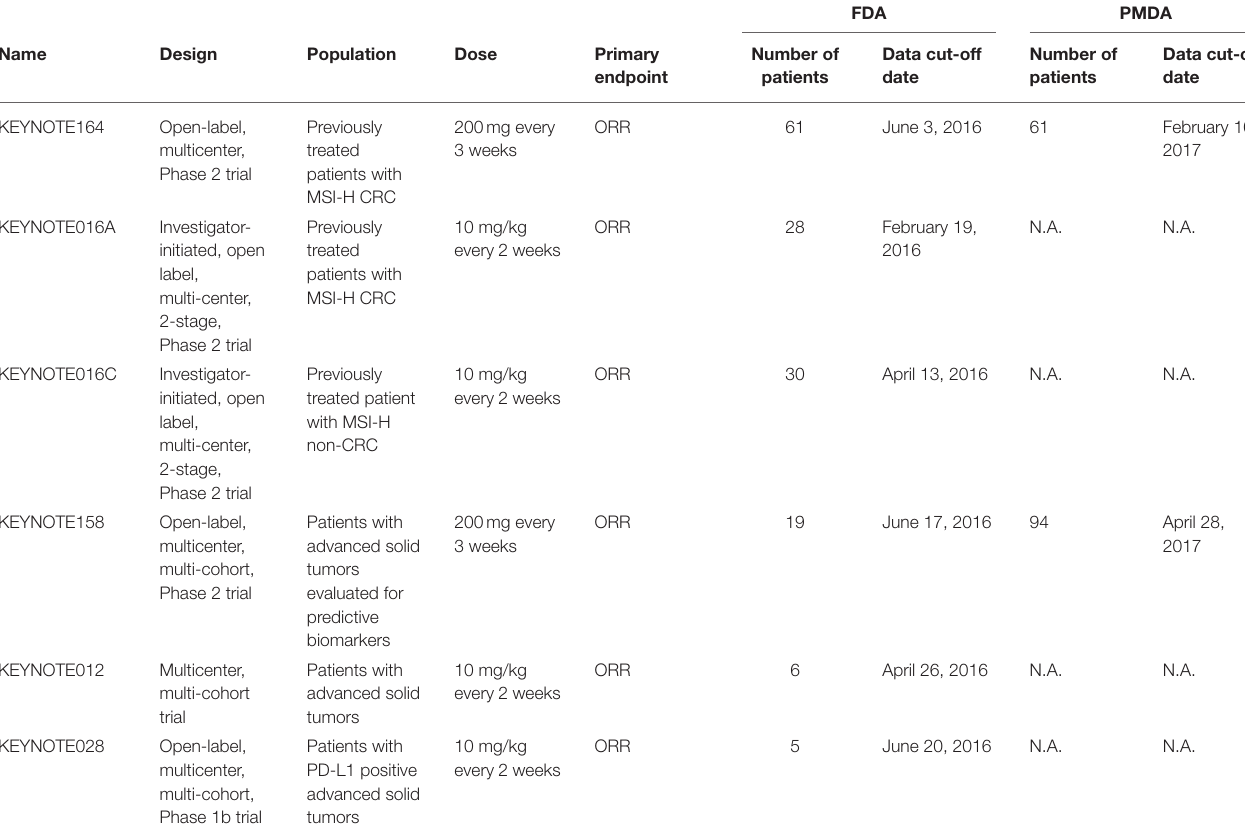
TABLE 1 | Clinical trials supporting the approval of pembrolizumab for the treatment of MSI-H/dMMR